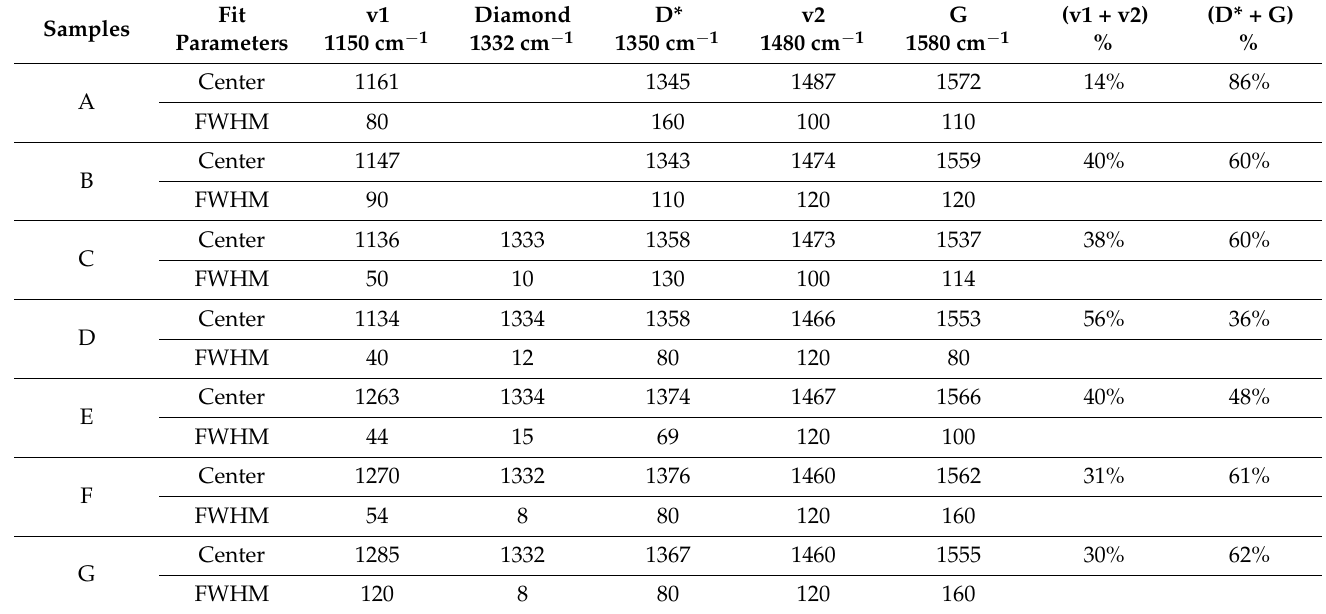
Table 3. Deconvoluted parameters of the Raman spectra using a Lorentzian distribution function.